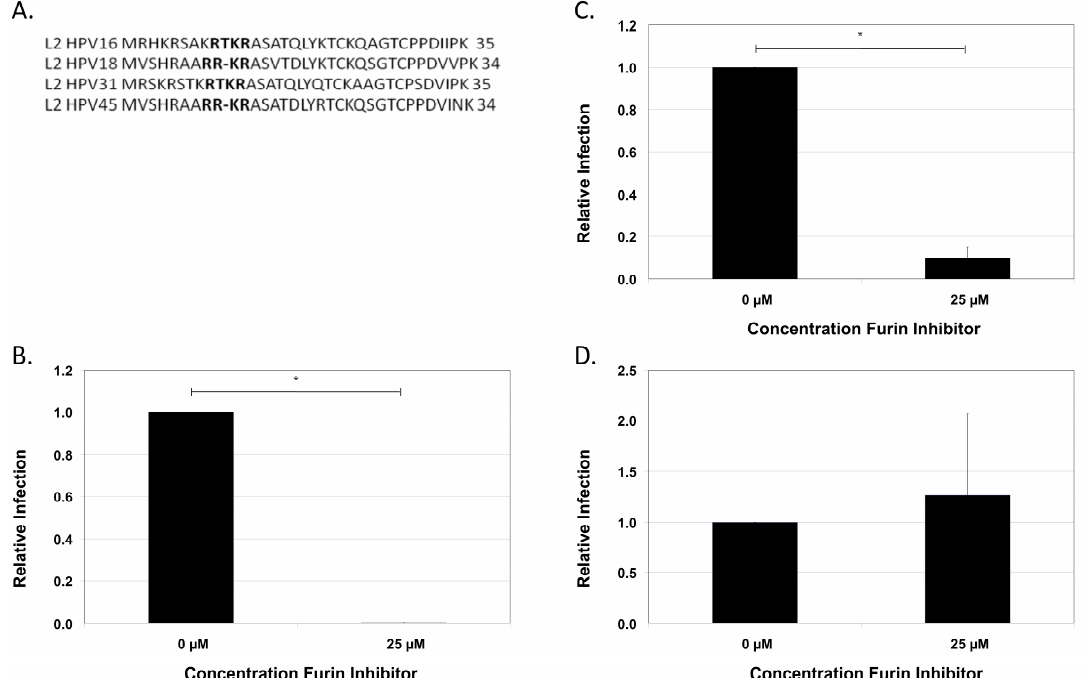
Figure 7. Furin inhibitory activities of other high-risk human papillomaviruses. ( A ) Alignment of the L2 N-terminal sequences of HPV16, HPV18, HPV31, and HPV45. A furin consensus site in each type is indicated in bold type. Infection of HaCaT cells with ( B ) HPV31 NV ( C ) HPV18 NV and ( D ) HPV45 NV in the presence or absence of 25 µM furin inhibitor. Infections were analyzed by RT-qPCR measuring the relative amount of E1^E4 transcript two days post-infection normalizing to infections done in the absence of furin inhibitor. The results are expressed as the means of at least three independent infections utilizing at least two different virus preps and standard deviations are shown. Statistical significance (denoted by asterisks) was determined by student’s t -test and significance was defined as p ≤ 0.05.